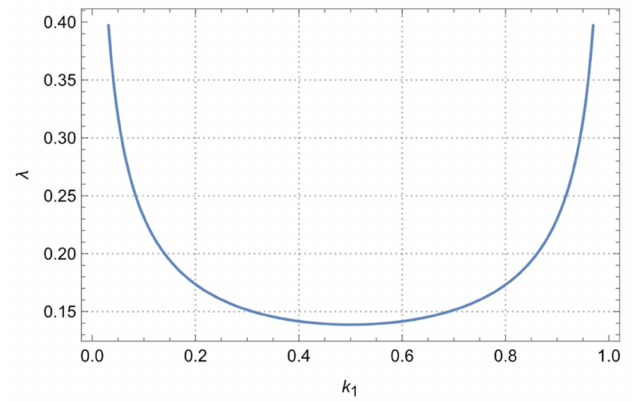
Figure 2. The upper frequency of the bandwidth for the 1st band or the width of this band, depending on the concentration of water in the air. Polydispersity k 1 + k 3 = k, k 3 = 0.2 ∗ k 1 , k 4 = 0.2 ∗ k 2 is taken into account here. The graph coincides with the case of a monodisperse distribution of media, k 3 = k 4 = 0. The most significant thing is that when k = 0.5 there is a global minimum of the width of the first frequency band as a function of linear